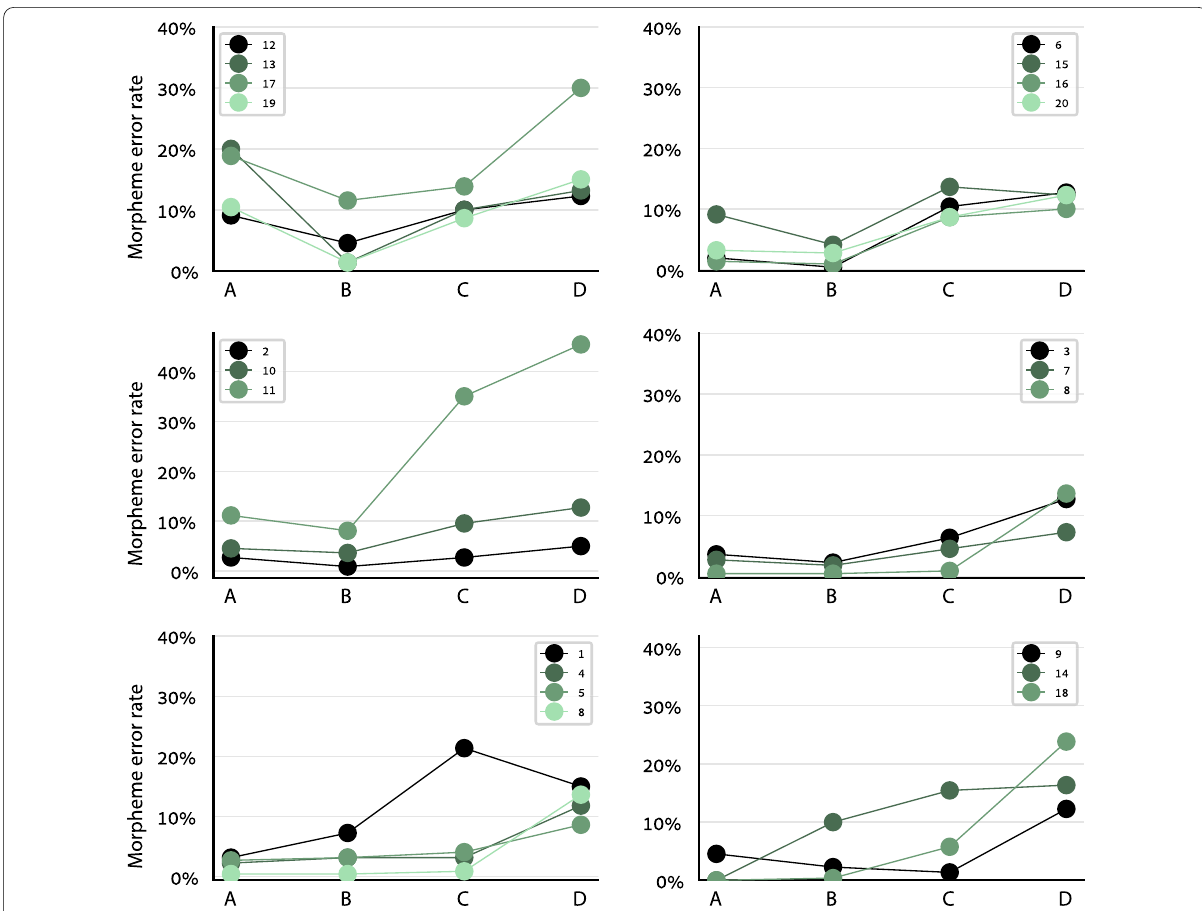
Fig. 4 Individual participant results in Experiment 1. Each line shows one participant (participant ID in the legend). The syntactic chunking effect, in particular the difference between conditions B and D, is clearly visible for each individual participant and was significant for most of them. The best-performance point was condition B for most participants, but for some it was condition A or C (bottom